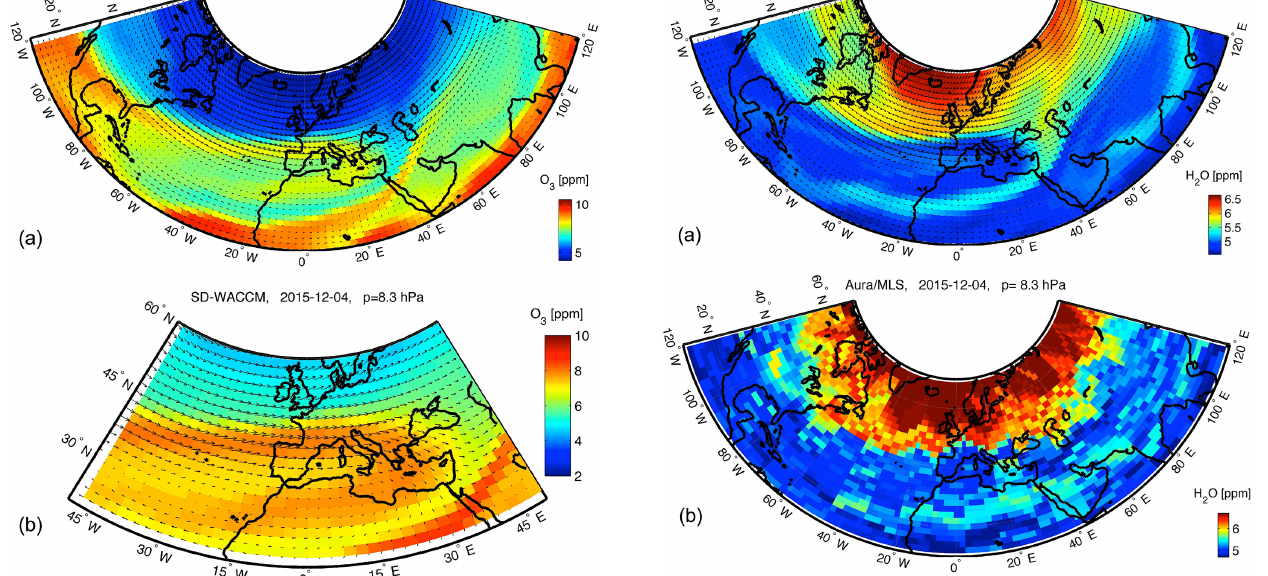
Figure 4. (a) Ozone distribution at 8.3hPa (ca. 34km altitude) on 4 December 2015 based on the SD-WACCM simulation. The figure indicates the effects of a breaking Rossby wave in the polar winter- time stratosphere. (b) Zoomed-in image of (a) : the Atlantic ozone streamer reaches central Europe and turns southward over eastern Europe. The largest arrows correspond to wind speeds of about 100 ms − 1 within the Atlantic streamer at 8.3hPa (34km).